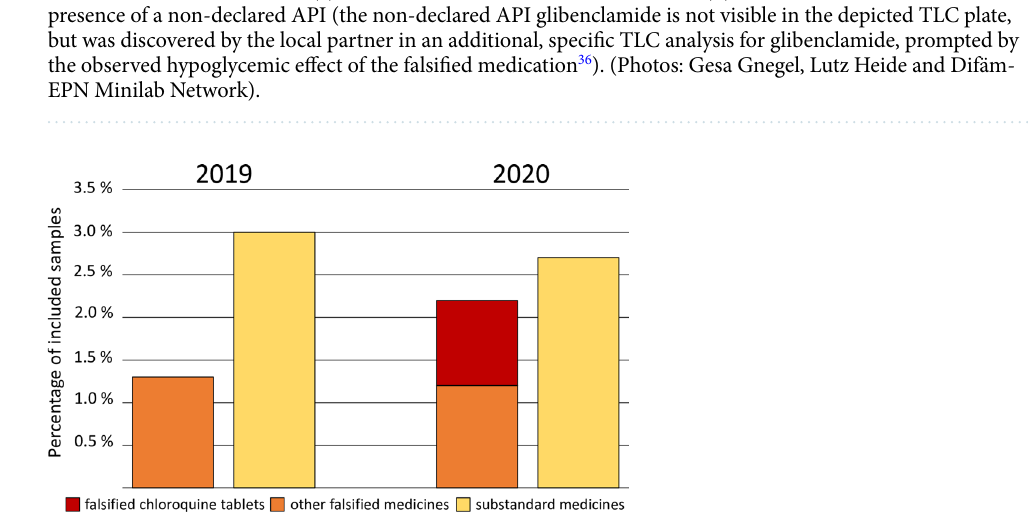
Figure 4. Changes of the occurrence of probably falsified and probably substandard medicines in the course of the COVID-19